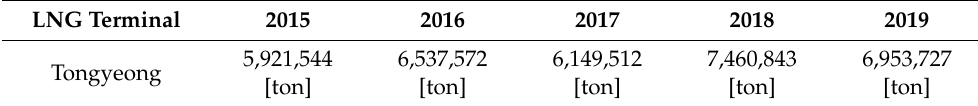
Table 3. Annual LNG supply at Tongyeong LNG receiving terminal from 2015 to 2019 [19].